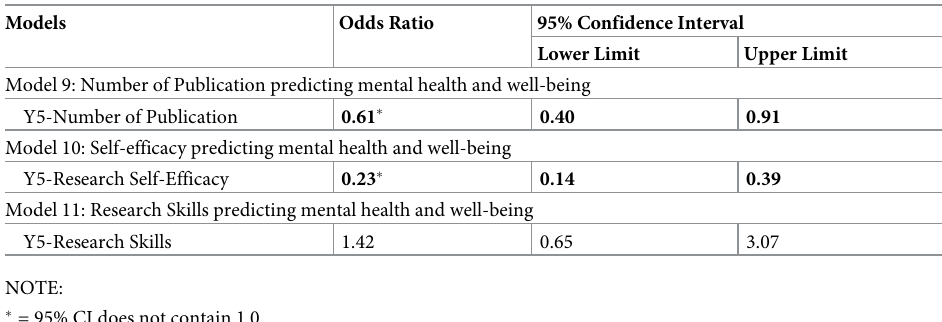
Table 3. Student outcomes and year 5 mental